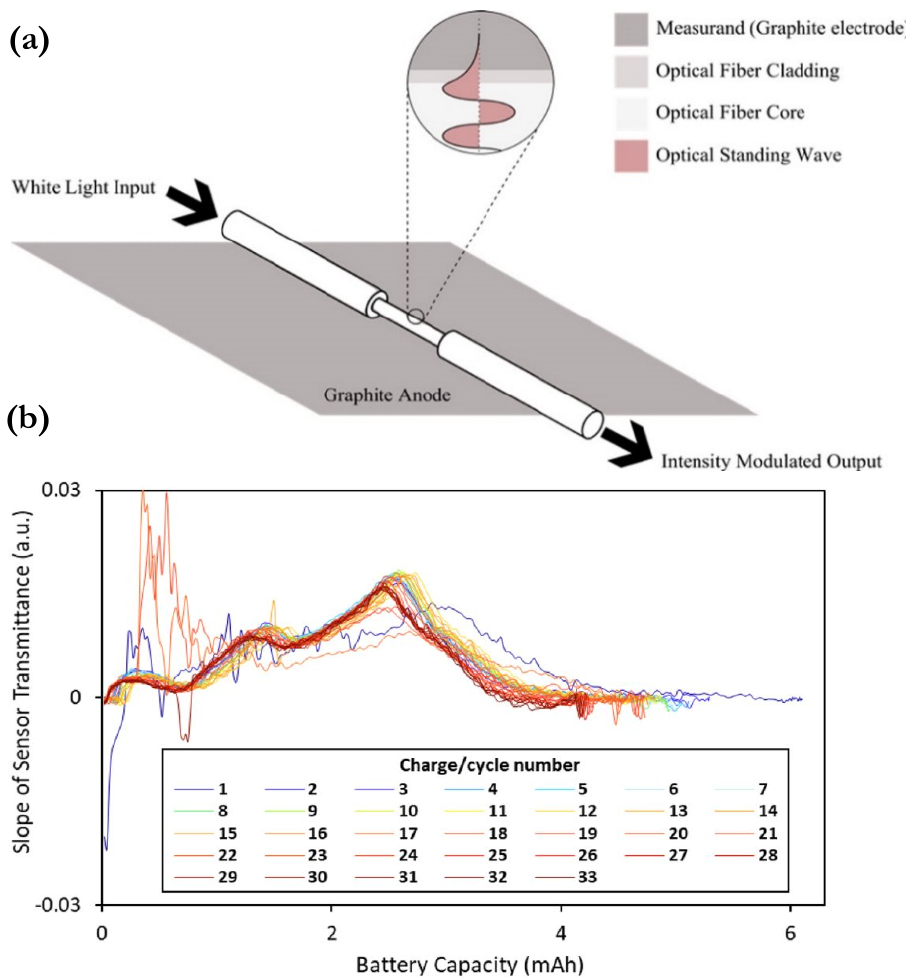
Figure 10. Fiber optic evanescent wave (FOEW) sensor in Li-ion cells: ( a ) schematic of FOEW sensor embedded onto graphite anode and evanescent wave (Reproduced with permission from Ghannoum et al., Applied Materials; published by American Chemical Society, 2016.) [130]; ( b ) correlation between charge capacity and the slope of optical transmittance of the embedded FOEW sensor (Reproduced with permission from Ghannoum et al. Journal of Energy Storage; published by Elsevier, 2020.) [129].